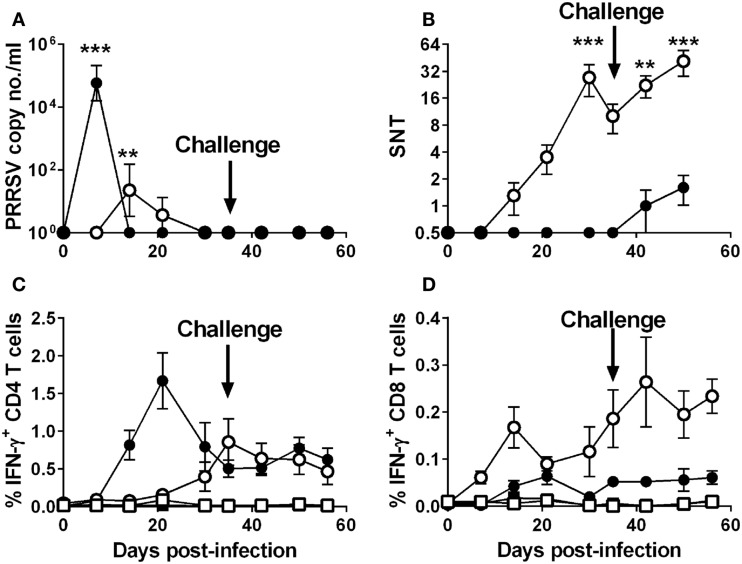
Outcome of infection and subsequent challenge infection with PRRSV-1 strains and association with virus-specific immune responses. Pigs were experimentally infected intranasally with either an attenuated PRRSV-1 strain (Olot/91; open symbols; n = 5) or a virulent sub-genotype 3 strain (SU1-Bel; closed symbols; n = 5) strains on day 0 and day 35 postinfection and PRRSV genome copy numbers in serum assessed (A). Serum neutralizing antibody titers (SNT) were assessed against PRRSV Olot/91 infectivity in vitro
(B). IFN-γ expression by CD4+CD8αlow (CD4) and CD4−CD8αhigh (CD8) T cells was assessed by flow cytometry following mock (square symbols) or homologous virus (circle symbols) stimulation [(C,D) respectively]. Results are expressed as the mean data for each group, error bars represent the SEM. For RT-qPCR data and VNTs, values were compared to the corresponding value on 0 dpi whereas for T cell IFN-γ data from virus-stimulated cultures were compared against the corresponding mock stimulated culture for each time point using a two-way analysis of variance (ANOVA) followed by a Tukey’s multiple comparison test; ***p < 0.001, **p < 0.01.